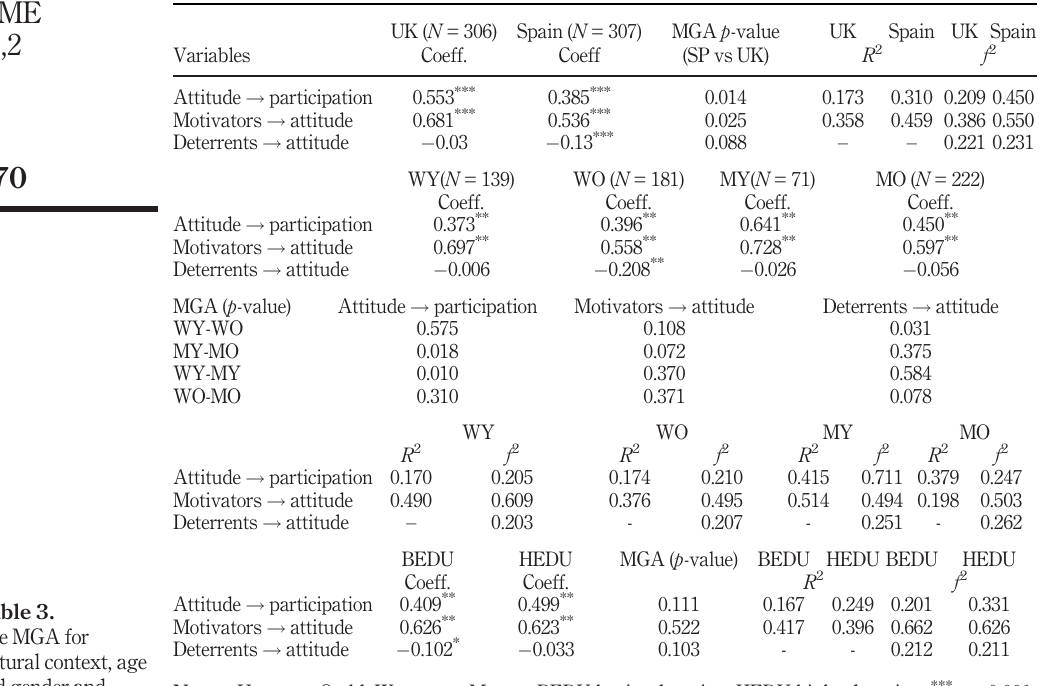
Table 3. The MGA for cultural context, age and gender and educational